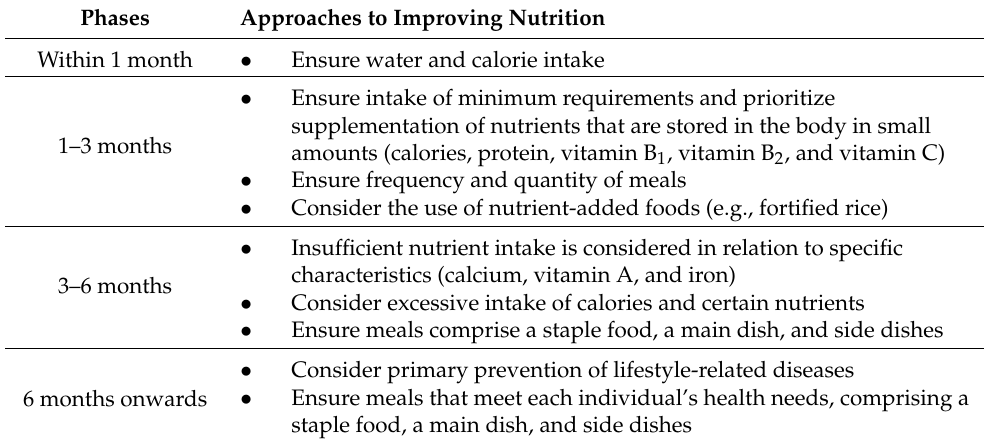
Table 8. Lines of thinking for nutrition improvement measures at evacuation shelters (excerpt).